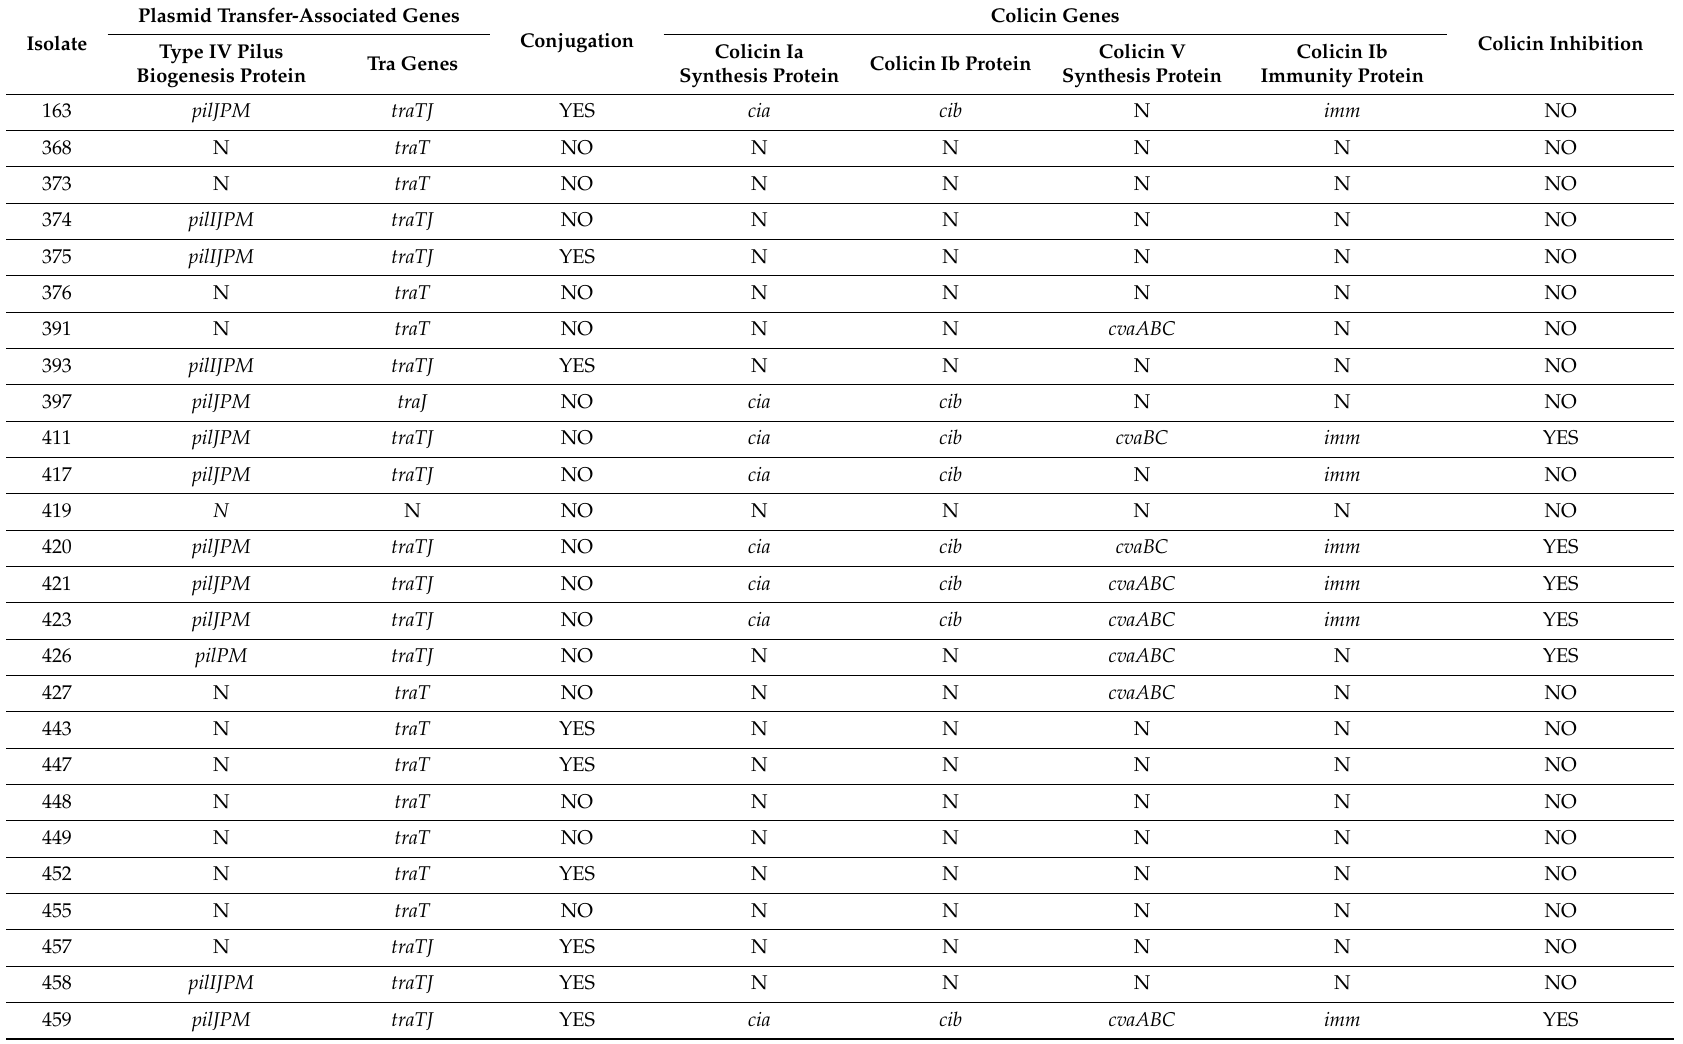
Table 2. Phenotypic and genomic results of colicin and conjugation assays for 71